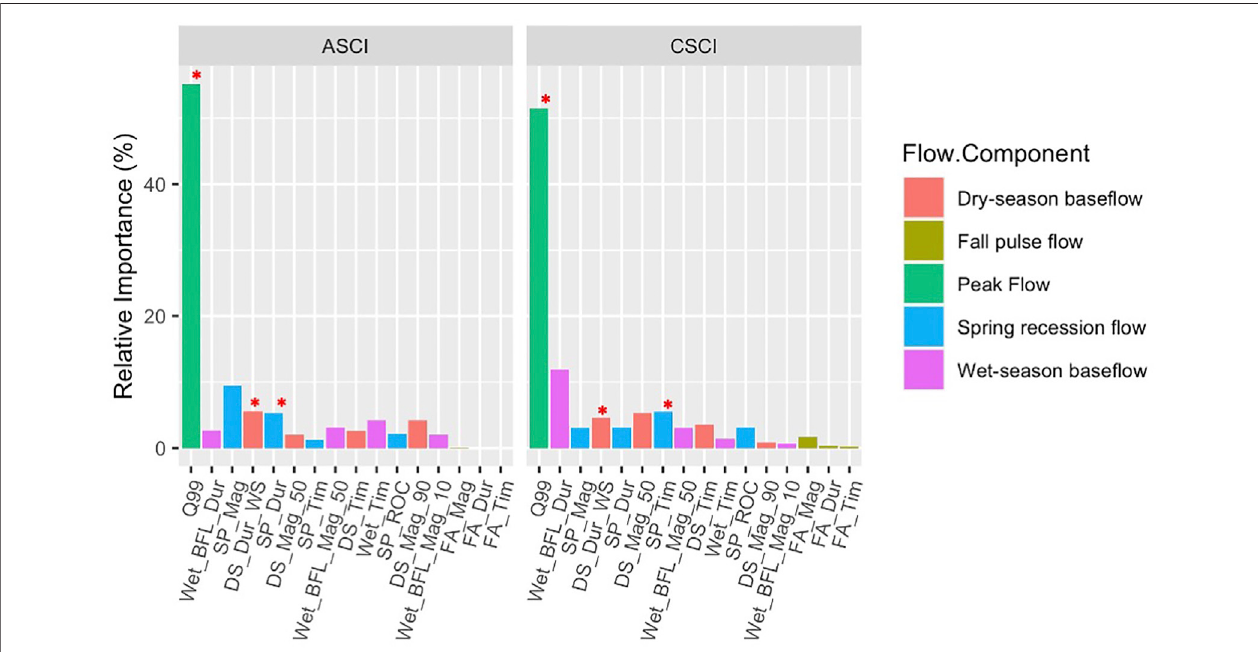
FIGURE 3 | Relative importance of FFM for each bioassessment index extracted from BRTs, color coded by fl ow component. Red stars indicate the chosen metrics.